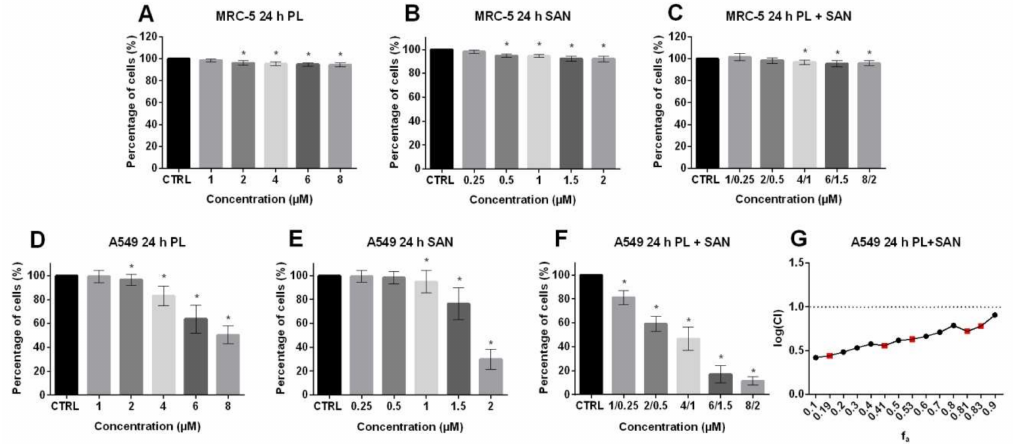
Figure 2. The cytotoxic e ff ects of piperlongumine (PL) and sanguinarine (SAN) individually and in combined treatment on the cell viability of MRC-5 and A549 cells. The analysis was based on the results obtained from the MTT assay. Cells were treated for 24 h with PL at concentrations 1–8 µ M ( A , D ); SAN at doses of 0.25, 0.5, 1, 1.5 and 2 µ M ( B , E ) and their combination in ratio 4:1 ( C , F ). Data represent the mean values ± SD obtained from 6 independent replicates ( n = 6). Statistically significant di ff erences in comparison to untreated cells, where survival was estimated as 100%, were marked as * ( p < 0.05; Wilcoxon test). ( G ) The combination index plot for the PL and SAN cotreatment in A549 cells in the range of fraction a ff ected (f a ) from 0.1 to 0.9. Combination index (CI) < 1—synergism, CI = 1—additive e ff ect and CI > 1—antagonism. For real measuring points, the values have been marked in